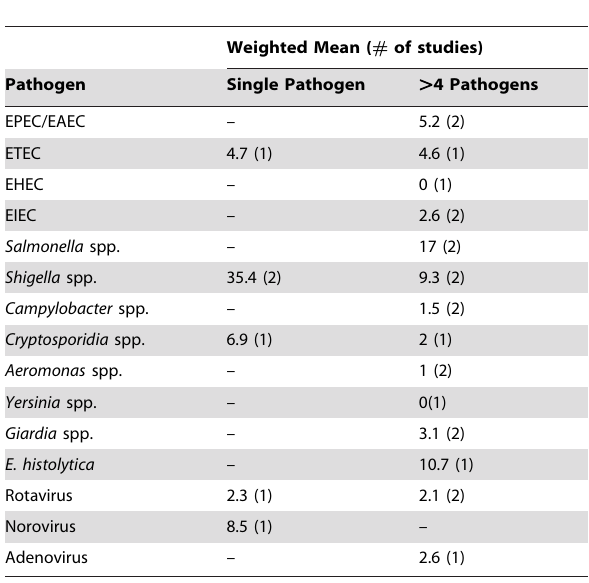
Table 6. Isolation of single vs. multiple pathogens for outpatient